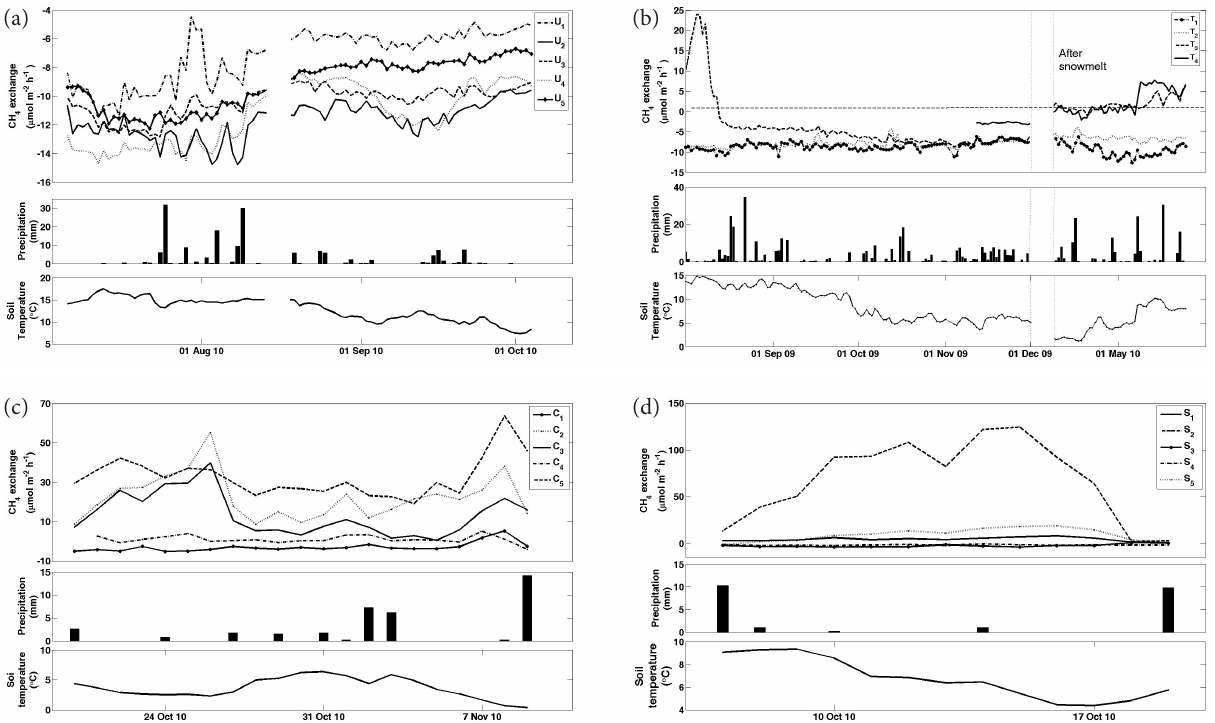
Figure 3. Time series of daily mean CH 4 exchange, daily precipitation and daily mean soil temperature at the measurement locations. (a) Undisturbed plot; (b) thinned plot; (c) clear-cut plot; (d) stump harvested